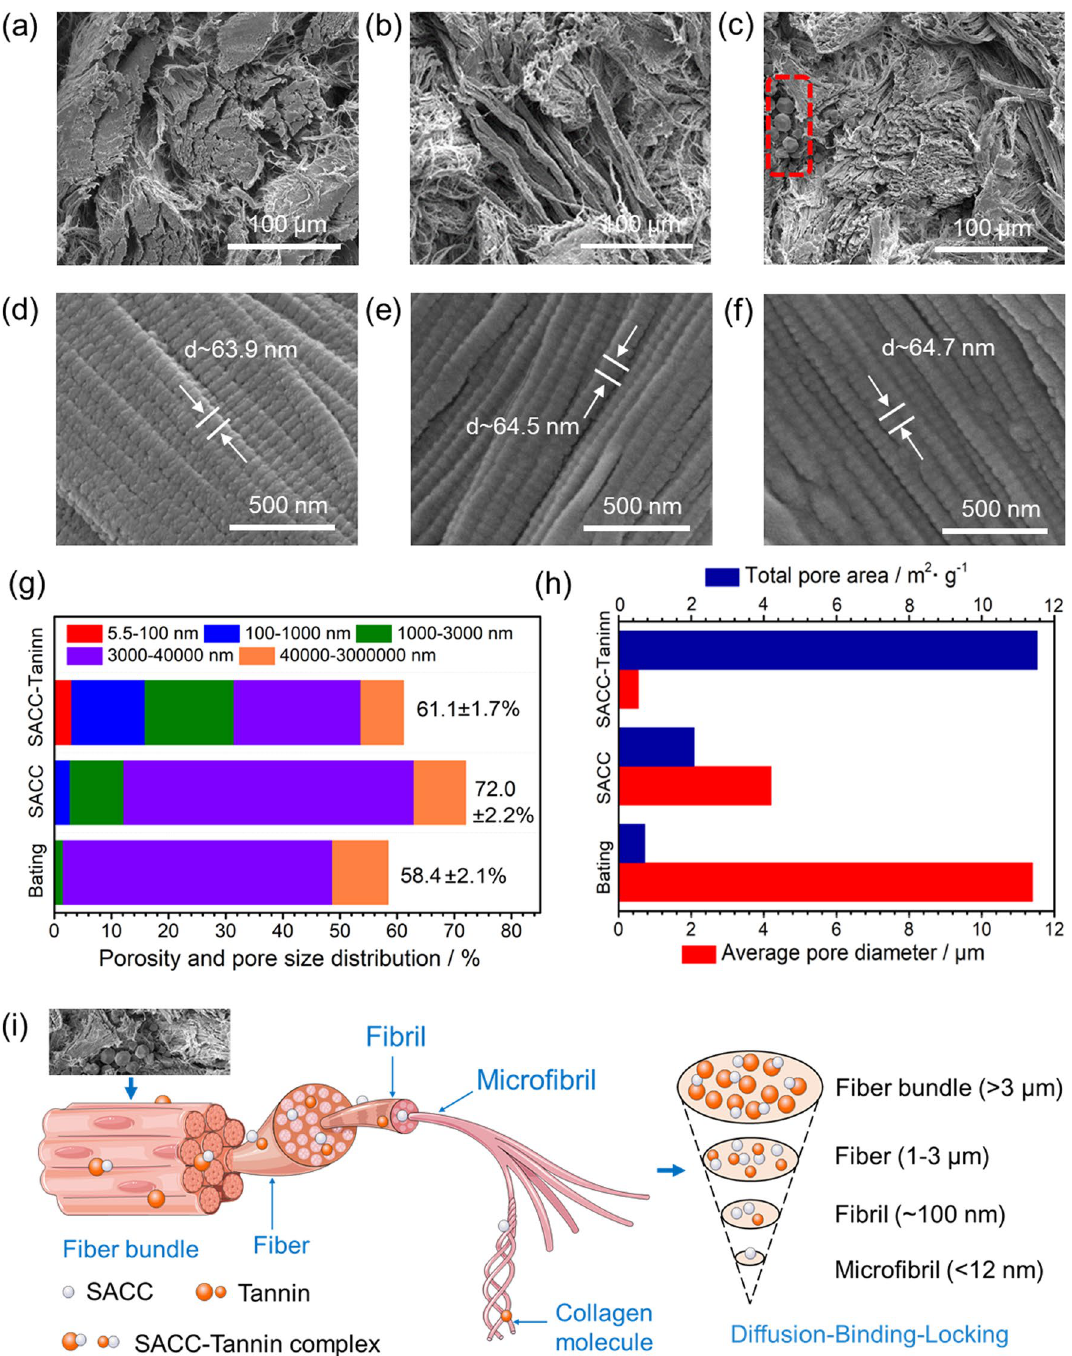
Fig. 4 Cross-section SEM of bating pelt ( a and d ), solo SACC tanned leather ( b and e ) and SACC-wattle combination tanned leather ( c and f ). Red dash frame in c indicates the SACC-tannin complexes. g Porosity and pore size distribution of tanned leathers. h Total pore area and average pore diameter of tanned leathers. i Schematic diagram of diffusion-binding-locking mechanism proposed in this combination tanning. The distribution of SACC-tannins in collagen was highlighted in multiple levels from collagen molecule to fiber